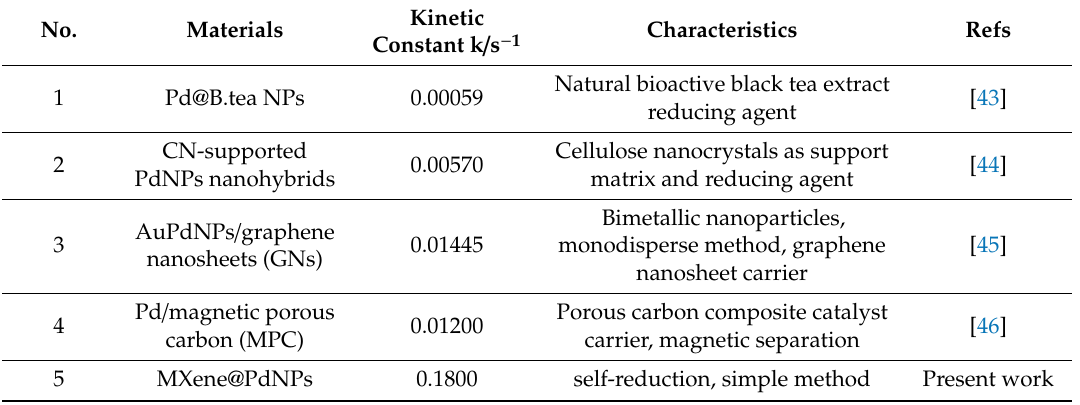
Figure 9. The cyclic catalytic capacity of MXene@PdNPs20 composite for the reduction of 4-NP ( a ), 2-NA ( b ) and morin ( c ). Table 1. Comparative characteristics and catalytic performance of PdNPs-based materials.